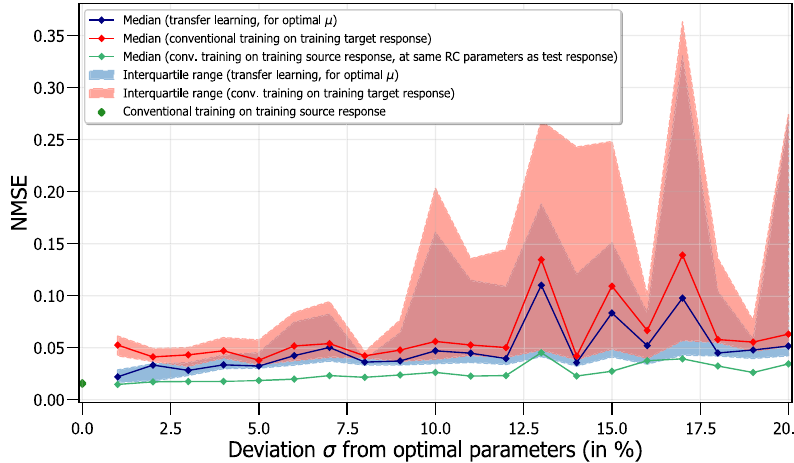
Figure 7: Median and interquartile range of NMSE as a function of the deviation from the optimal parameters of injection rate, feedback rate and excess pump current rate, for one-step ahead prediction of Santa Fe data. 10 different parameter combinations are used for the calculations of the median and interquartile range, where the same mask is reused for every